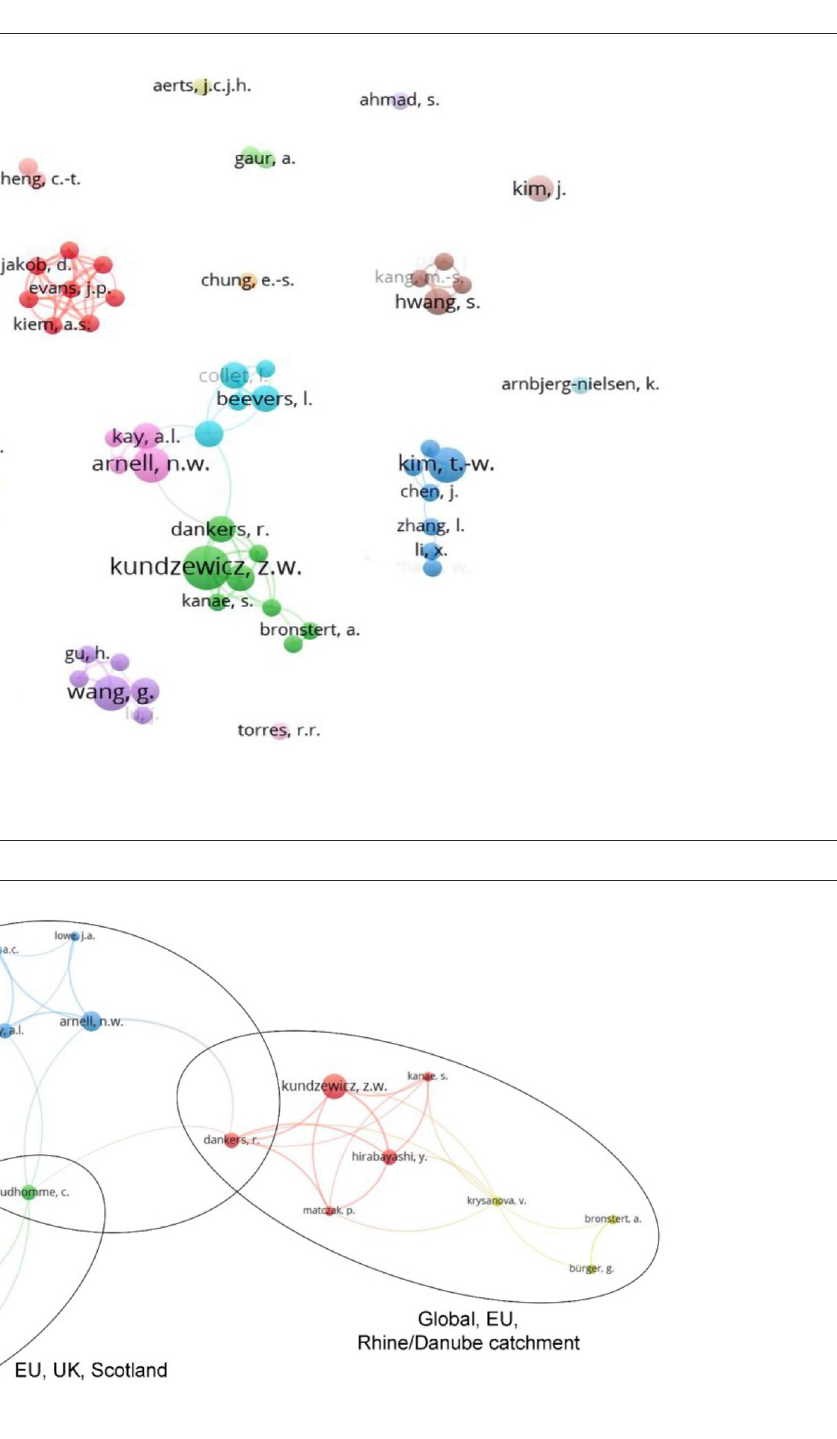
FIGURE8 Relationship among few authors’